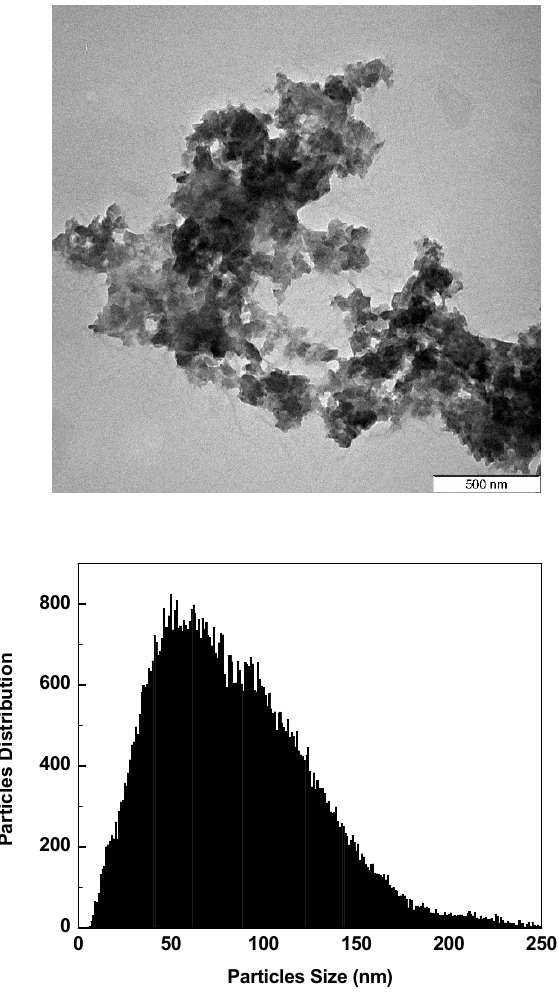
Figure 14. TEM images of MET-CS-AlgNPs ( A ) and their particle size distribution ( B ). 406